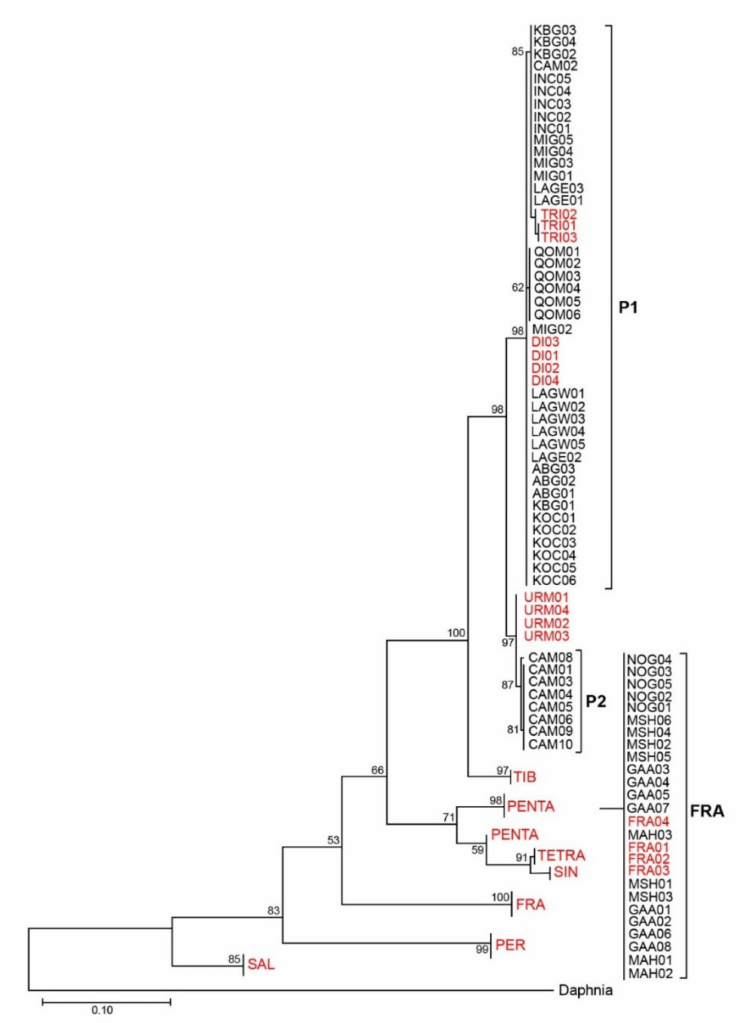
Figure 2. Phylogenetic tree of Artemia using COI sequences based on the ML approach. The number behind major nodes denotes bootstrap confidential values. Daphnia tenebrosa (HQ972028) was used